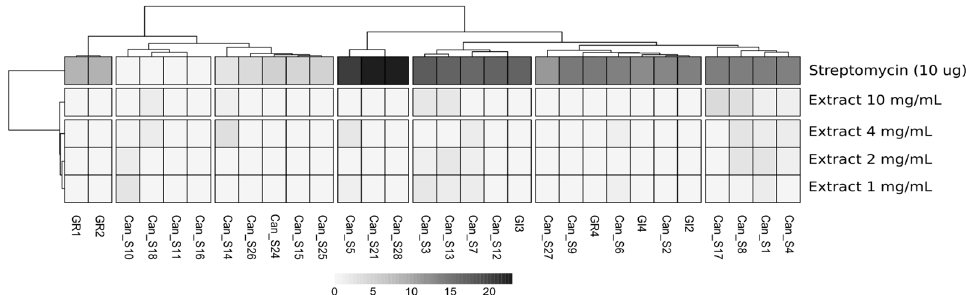
Figure 3. Heatmap showing the halo measures obtained after the exposure of the isolated strains to the seeds extract at four different concentrations, together with streptomycin. The values are the averaged measures of three replicates, normalized by removing the measures of the halos obtained with 80% EtOH, which was used as a solvent for seed extraction and dilution.